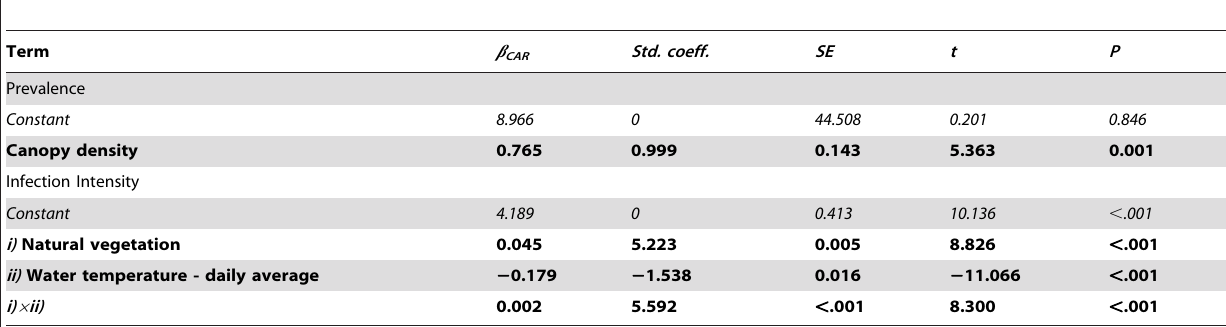
Table 1. Conditional autoregressive models (CAR) simultaneously testing the effects of natural vegetation, canopy density, and water temperature on Bd prevalence and infection intensity in amphibian populations from the Adirondack region, New York, USA.